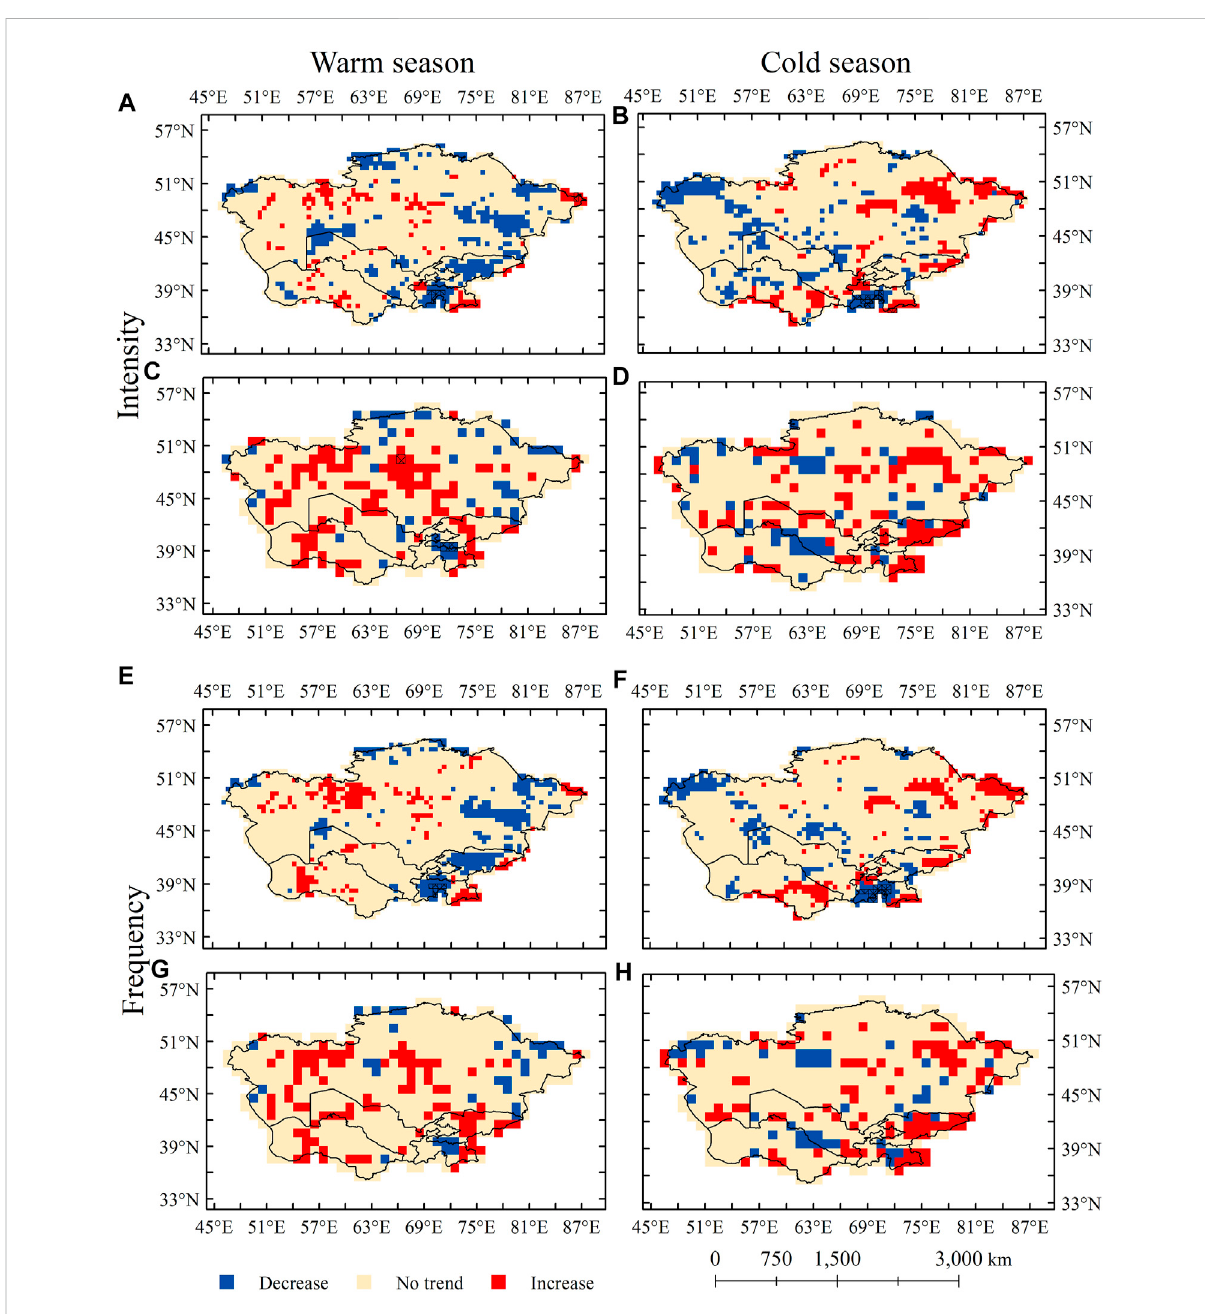
FIGURE 10 Spatial distribution for intensity and frequency of extreme precipitation trend with signi fi cance by APHRODITE (A,B,E,F) and GPCC (C,D,G,H) datasets over Central Asia from 1985 to 2005. (The trend: at a signi fi cance level of 10% by the MK test; grid with shadow: a grid with a consistent signi fi cant trend in different threshold